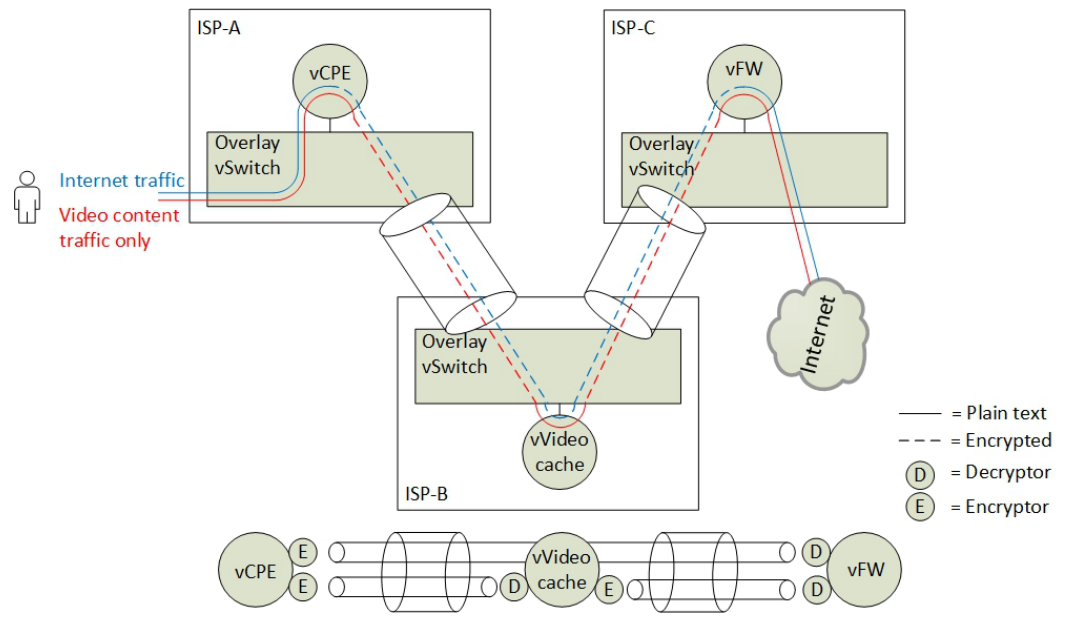
Figure 2. Proof-of-Concept